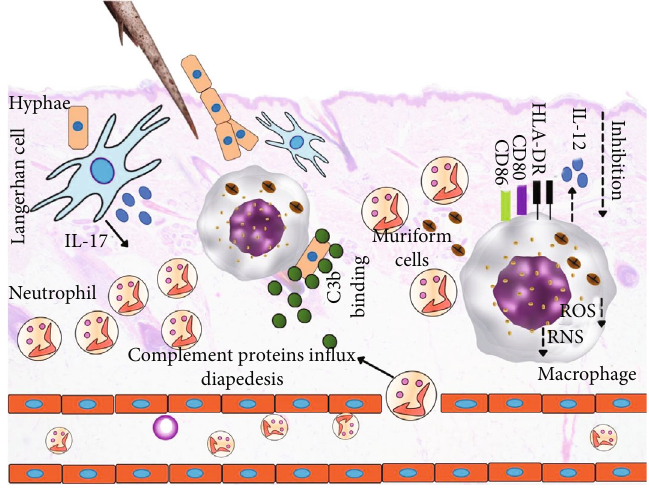
Figure 4: A prototype scheme of induction of innate immunity in chromoblastomycosis. Upon a traumatic injury with sharp objects contaminated with hyphae forms of pathogenic fungi, morphological and phenotypic changes occur in the endothelium, allowing the in fl ux of in fl ammatory mediators, such as complement system proteins and neutrophils. C3b-opsonized hyphae are phagocytosed by macrophages; however, di ff erentiation into muriform cells prevents the destruction of fungi. Furthermore, muriform cells and their antigens inhibit the expression of MHC class II and the costimulatory molecules (CD80 and CD86) of macrophages and dendritic cells. Production of IL-12 cytokine, NOS, and ROS is suppressed. Inhibition of these molecules alters the communication between innate and acquired immune responses. Additionally, the accumulation of antigens in dendritic cells favors the production of IL-17 cytokines, which attracts a second wave of neutrophils to the site of infection. Although neutrophils phagocytosed muriform cells, the fungi are resistant to destruction caused by the microbicidal molecules of such